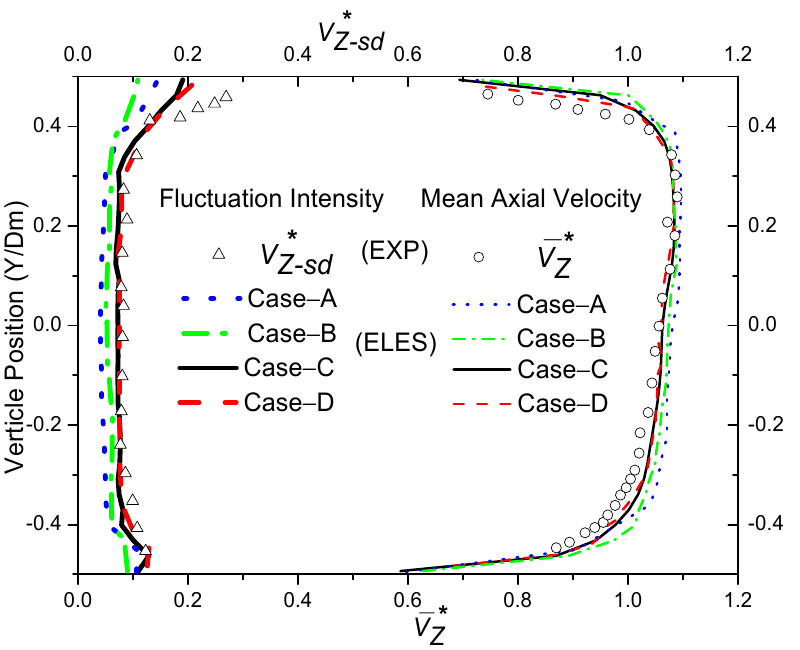
Figure 4. Mean axial velocity and velocity fluctuations distributions along a vertical line ( Z = − 0.53 D m ) in the W-ref case for four types of grids.